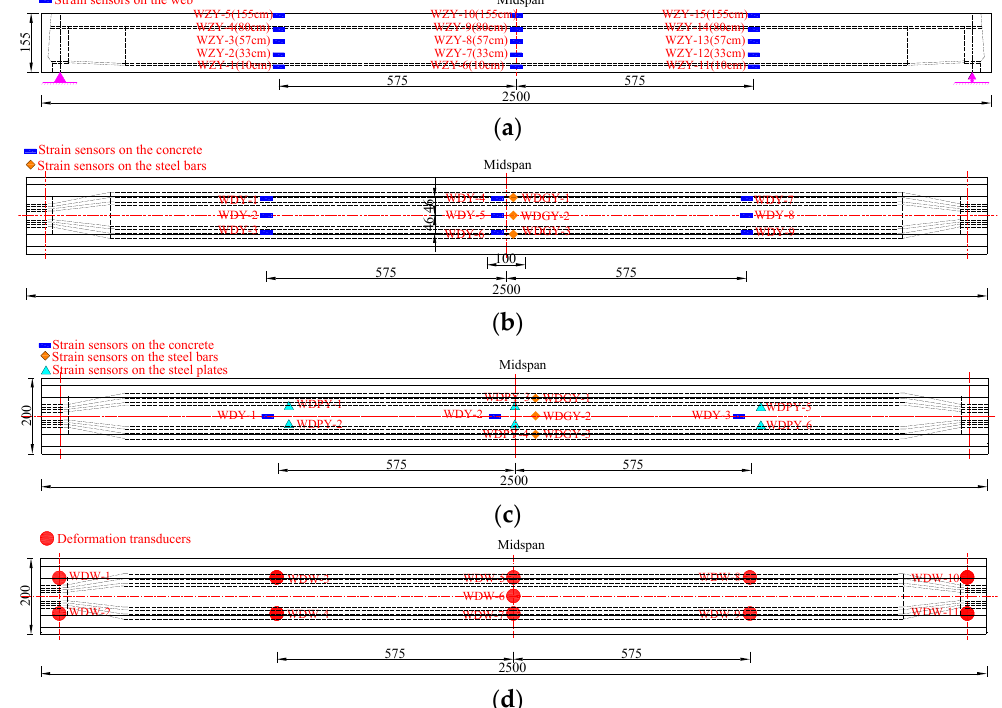
Figure 17. Sensor arrangements for the destructive test (Unit: cm). ( a ) Strain sensor arrangement at the concrete web; ( b ) Strain sensor arrangement at the concrete bottom and steel bars of the undamaged #4-1 girder; ( c ) Strain sensor arrangement at the concrete bottom and steel bars of the repaired #3-2 girder strengthened by steel plates; ( d ) Deformation sensor arrangement at the bottom of the girder.